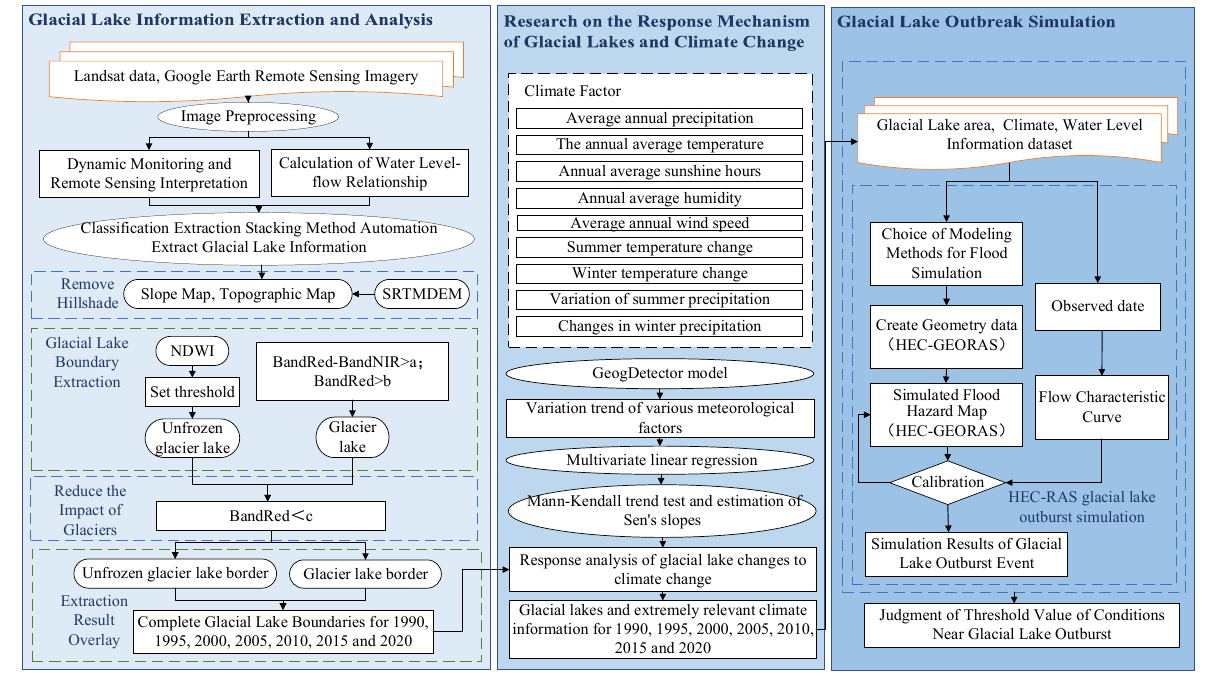
Figure 2. Flow chart of the methodology.